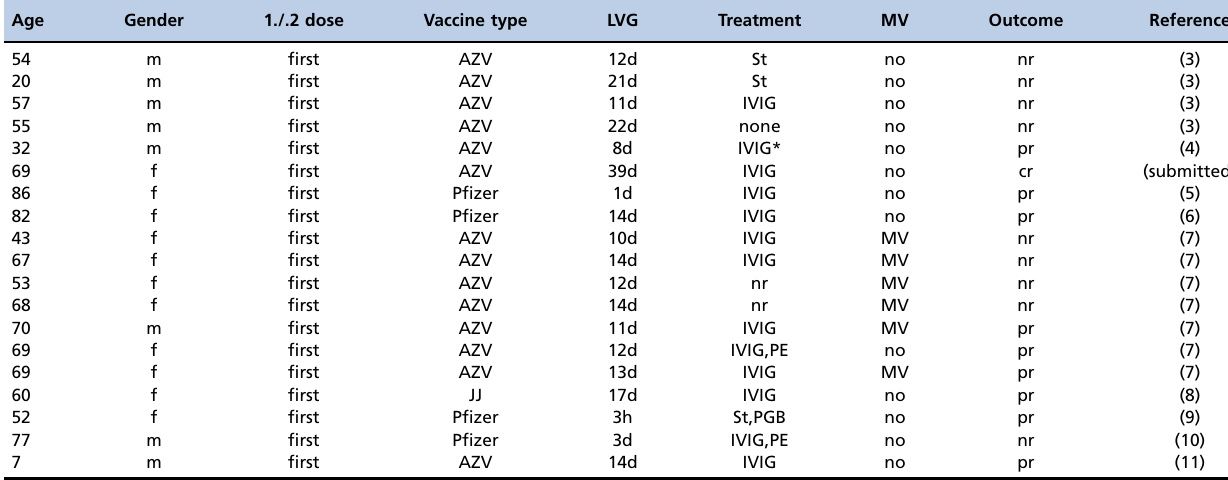
Table 1 - Patients developing GBS after SARS-CoV-2 vaccination. Age Gender 1./.2 dose Vaccine type LVG Treatment MV